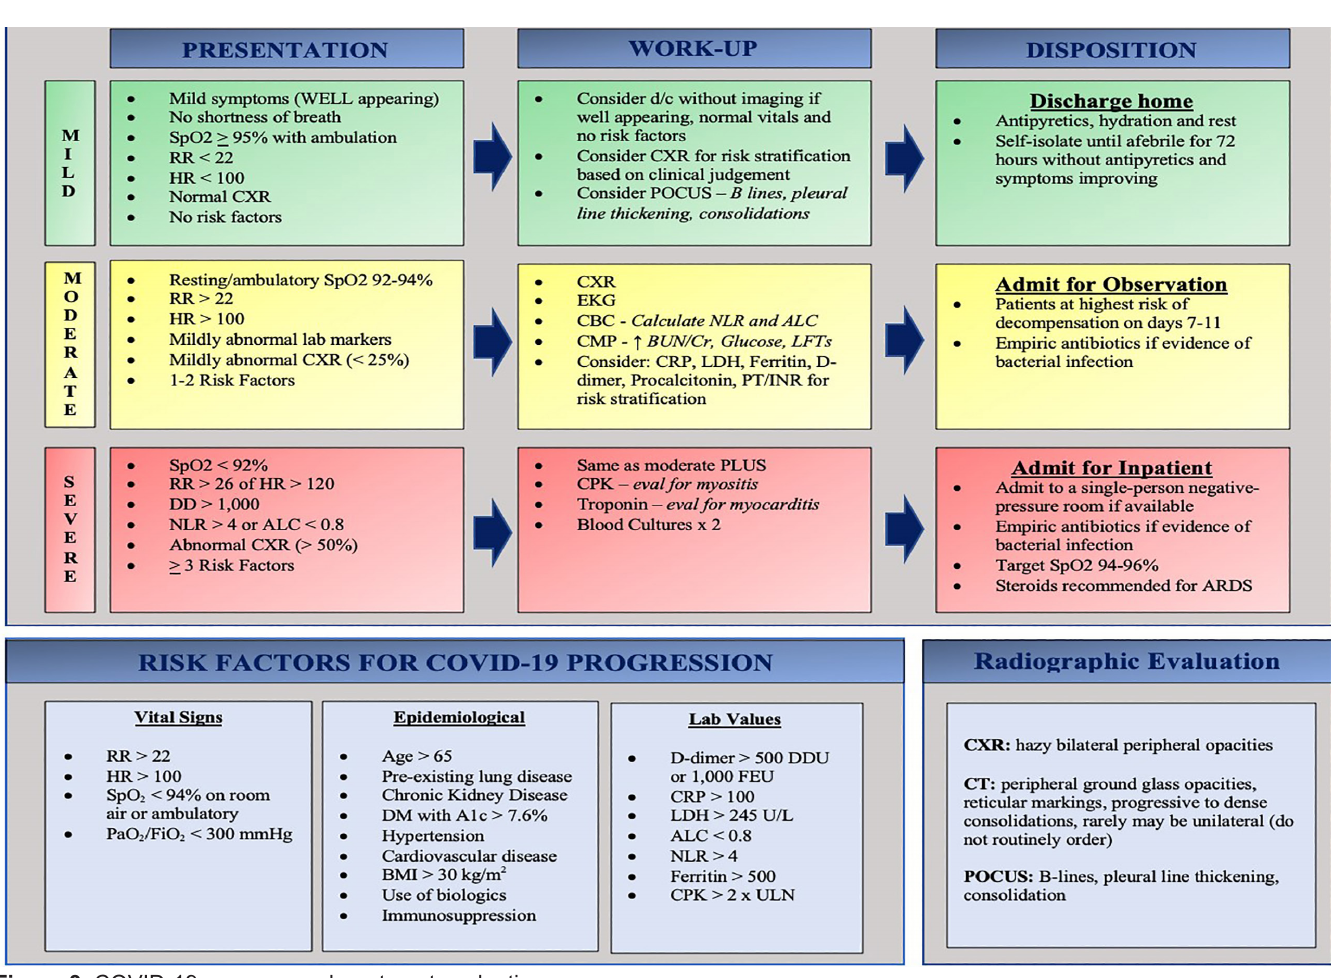
Figure 3. COVID-19 emergency department evaluation. SpO , peripheral capillary oxygen saturation; RR, respiratory rate; HR, heart rate; d/c, discharge; CXR, chest radiograph; US, ultrasound; 2 POCUS, point-of-care ultrasound; EKG, electrocardiogram; CBC, compete blood count; NLR, neutrophil to lymphocyte ratio; ALC, absolute lymphocyte count; CMP, comprehensive metabolic panel; BUN, blood urea nitrogen; CR, creatinine; LFT, liver function test; CRP, C-reactive protein; LDH, lactate dehydrogenase; PT/INR, prothrombin time/international normalized ratio; CPK, creatine phosphokinase; ARDS, acute respiratory distress syndrome; PaO ; partial pressure of oxygen; FiO ; fraction of inspired oxygen; DM, diabetes mellitus; 2 2 BMI, body mass index; CT, computed